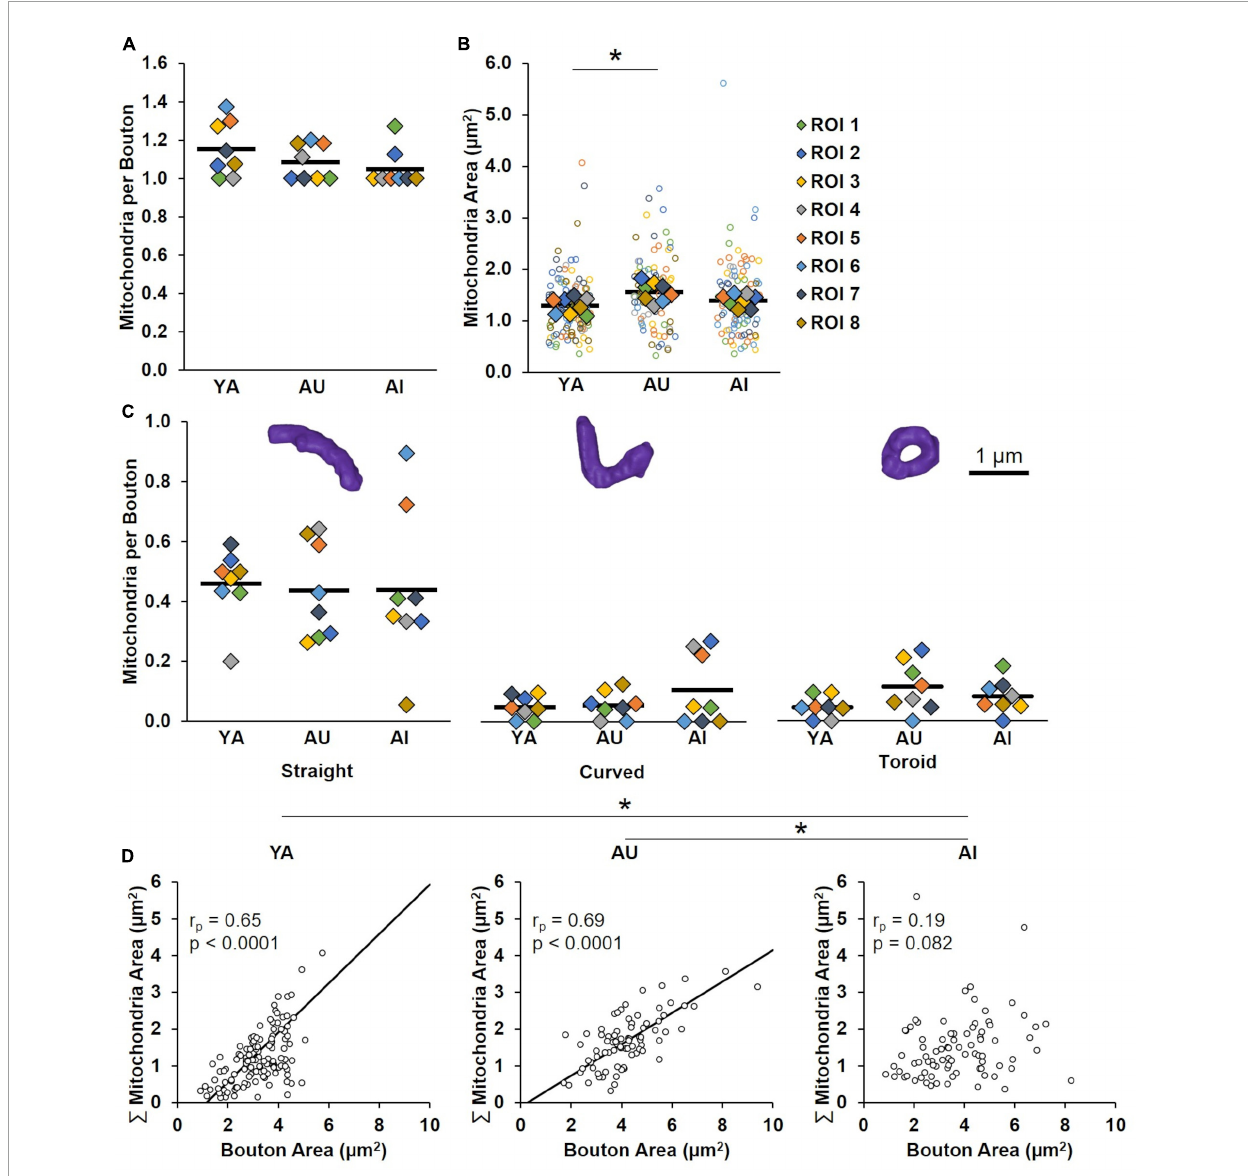
FIGURE6 Presynaptic mitochondria. (A) Average number of mitochondria per bouton. The number of mitochondria per bouton was similar in young and aged marmosets, regardless of cognitive status. (B) Synaptic mitochondria size. The size of synaptic mitochondria from AU were larger than those from YA. Mitochondria from AI were statistically similar in size to both YA and AU. (C) Average number of mitochondria per bouton by morphological class. Note that all animals had a greater proportion of mitochondria that were straight compared to both curved and toroidal. Within each morphological class there were no differences between animals. (D) Correlations between bouton size and mitochondria size by animal. While the sizes of mitochondria and boutons in YA and AU are highly correlated, these synaptic components are not correlated in AI. Open circles show each individual data point. Colored diamonds in (A–C) represent the average of measures taken in each of the ROIs, and horizontal black bars represent average across the ROIs. * p < 0.05.